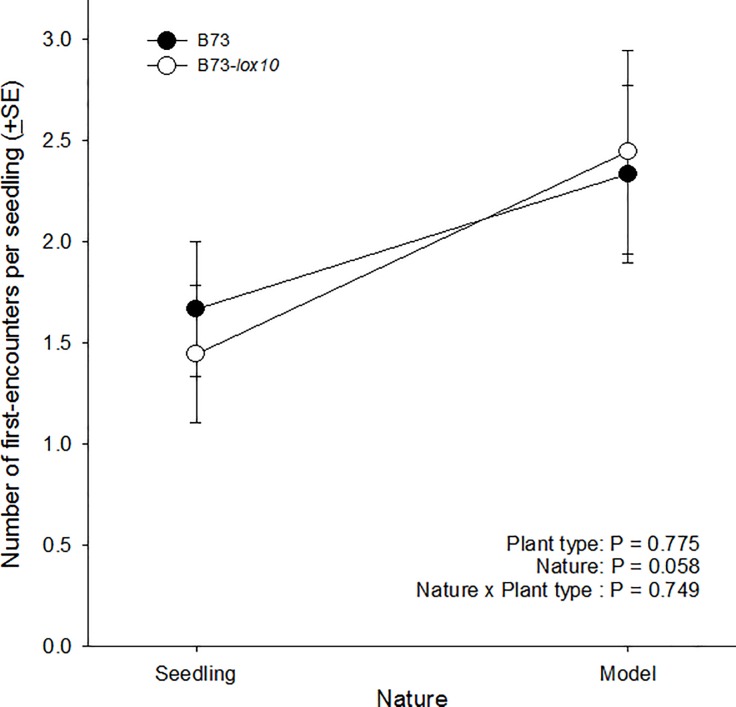
Host finding by older (3rd-instar) larvae in relation to host plant volatiles.The attraction of 3rd-instar larvae to model (constructed of plastic and metal wire) or real seedlings of two maize inbred lines, B73-lox10 and B73, was assessed in a paired choice-test, independently for each inbred line. In each trial, ten 3rd-instar larvae were released in the center of a circular arena in which three each, model and real (B73 or B73-lox10) seedlings were positioned along the arena’s margin. After release, larvae were monitored for 5 min, and first-encounters of larvae with a seedling were recorded by observing then removing larvae immediately upon encountering a seedling. First-encounters of larvae with seedlings were unaffected by plant nature (model or real seedling, F1, 32 = 3.883, P = 0.058), maize inbred line (B73 or B73-lox10, F1, 32 = 0.083, P = 0.775), or any interaction between those variables (F1, 32 = 0.104, P = 0.749). In the plot, maize inbred line is indicated with open (B73-lox10) or closed (B73) circles, and seedling nature (real or model) is on the horizontal axis.